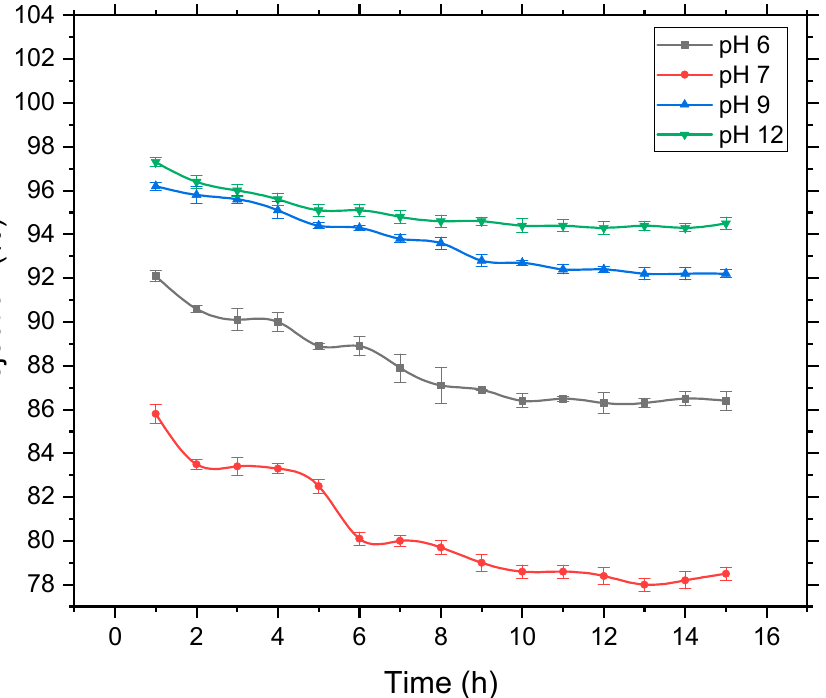
Figure 8. Rejection of 10 − 4 M 4-NP solution versus time using PPSU 20 /PES 9 membrane at various solution pH, 25 °C, and 3 bar.